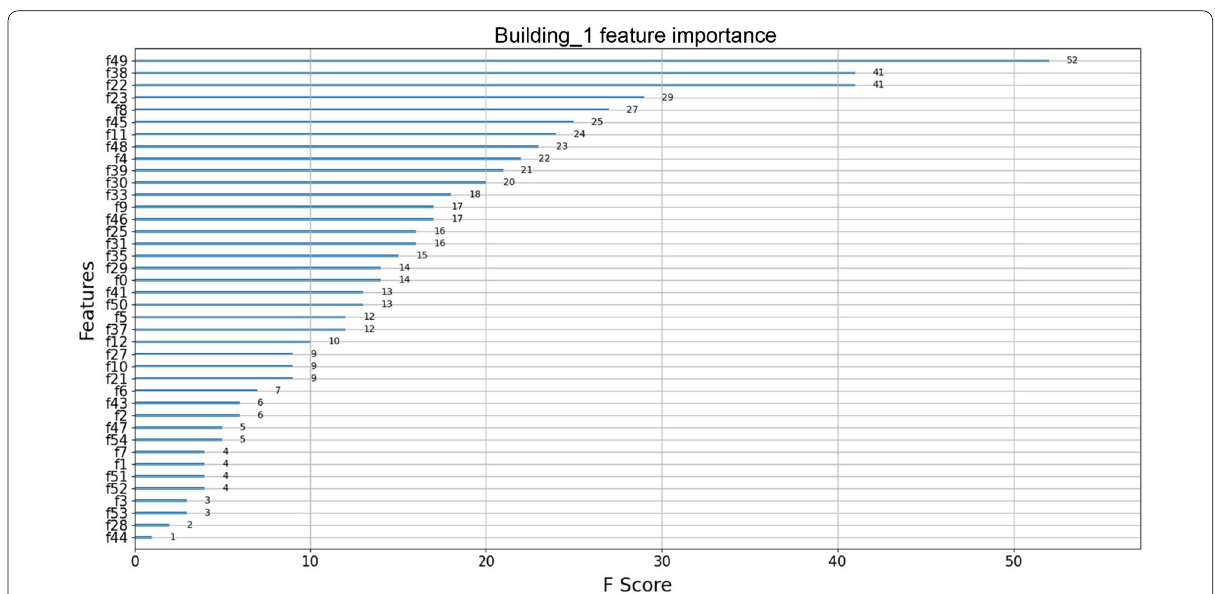
Fig. 11 The score of each feature using the data which comes from Building1